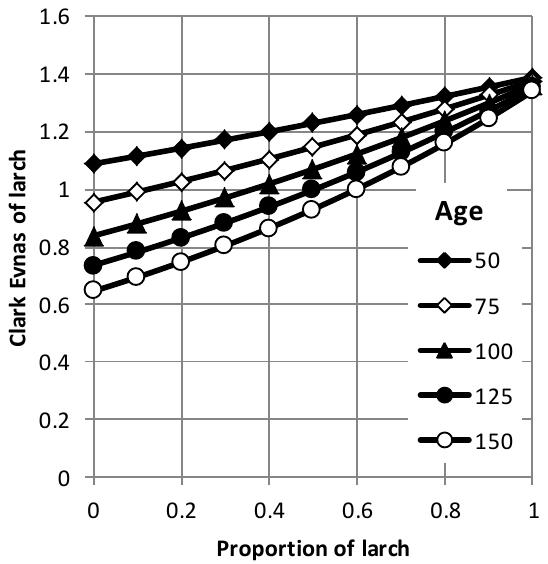
Figure 10. The Clark Evans index of larch, depending on stand age and the proportion of larch.